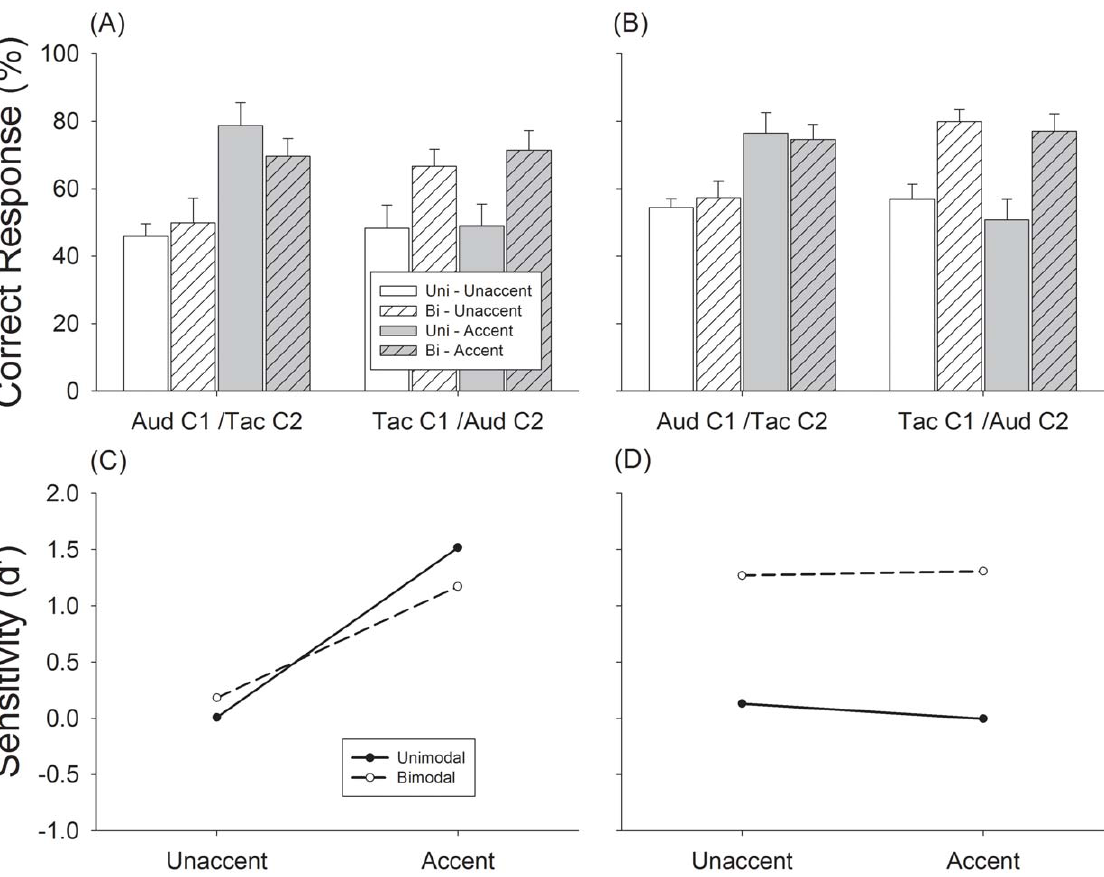
Figure 6. Results of Experiment 3, meter recognition performance with triple sequences (A) and duple sequences (B). (A) Correct responses to triple sequences. (B) Correct responses to duple sequences. Open bars: unaccented condition data. Gray bars: accented conditions. Hashed open bars: bimodal conditions. Hashed gray bars: bimodal accented conditions. Error bars are standard error. (C) Discriminability analysis of meter perception with Aud-C1/Tac-C2 condition; (D) Discriminability analysis of meter perception with Tac-C1/Aud-C2 condition. Open bars are unimodal unaccented control condition, hashed bars are bimodal unaccented condition; gray bars are unimodal accented control condition, and hashed gray bars are bimodal accented condition.